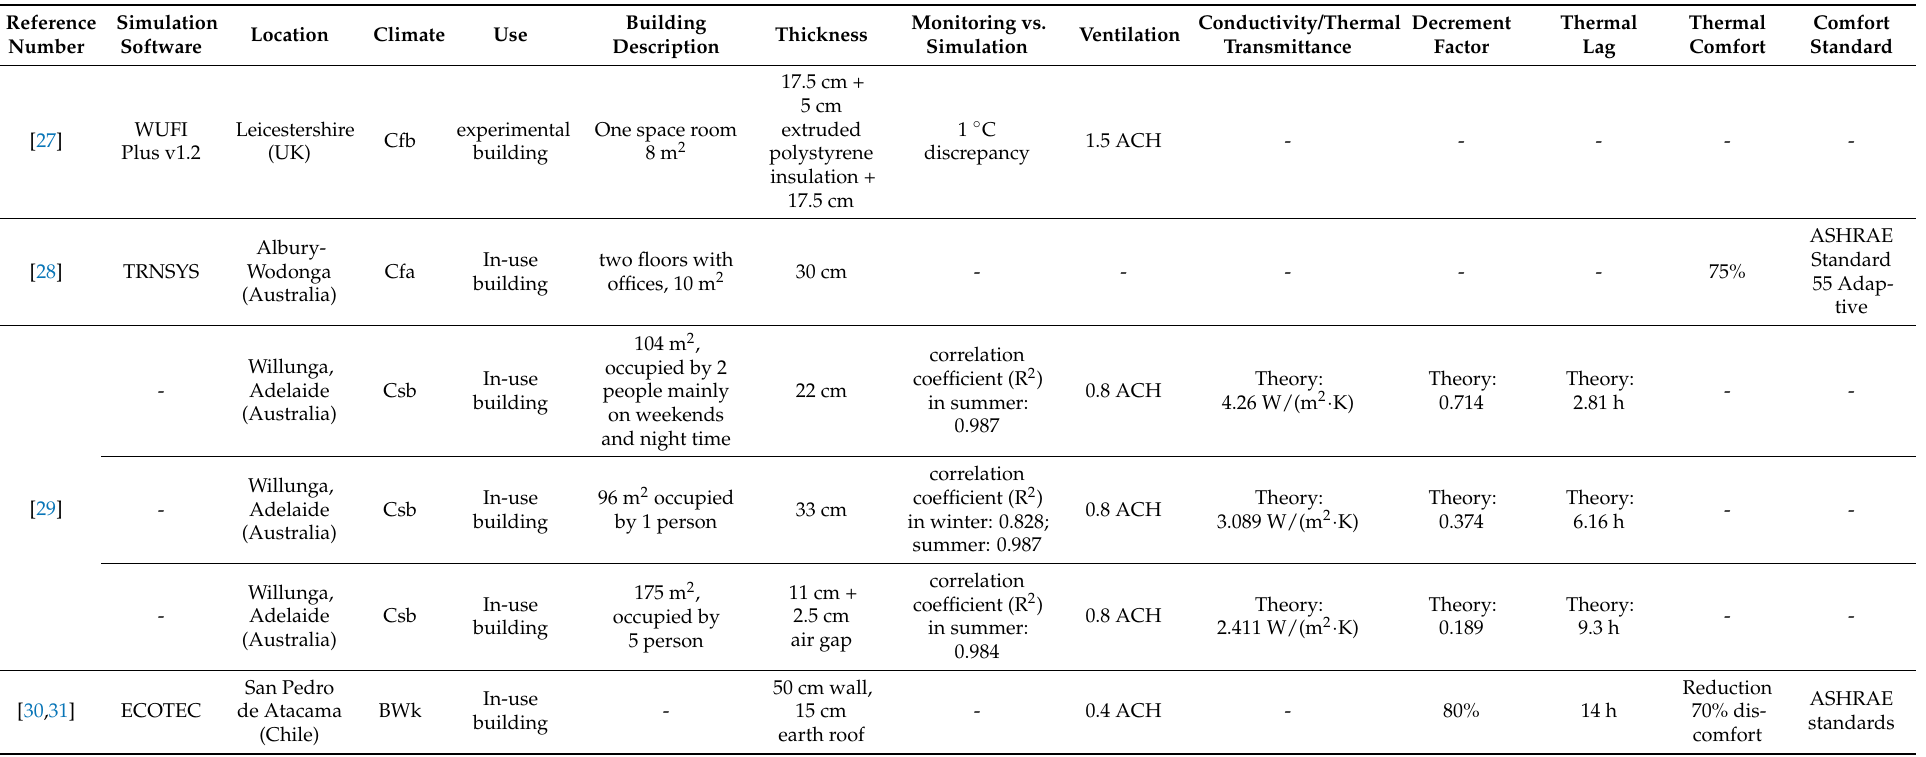
Table 7. Building characteristics and thermal performance of the rammed earth simulated